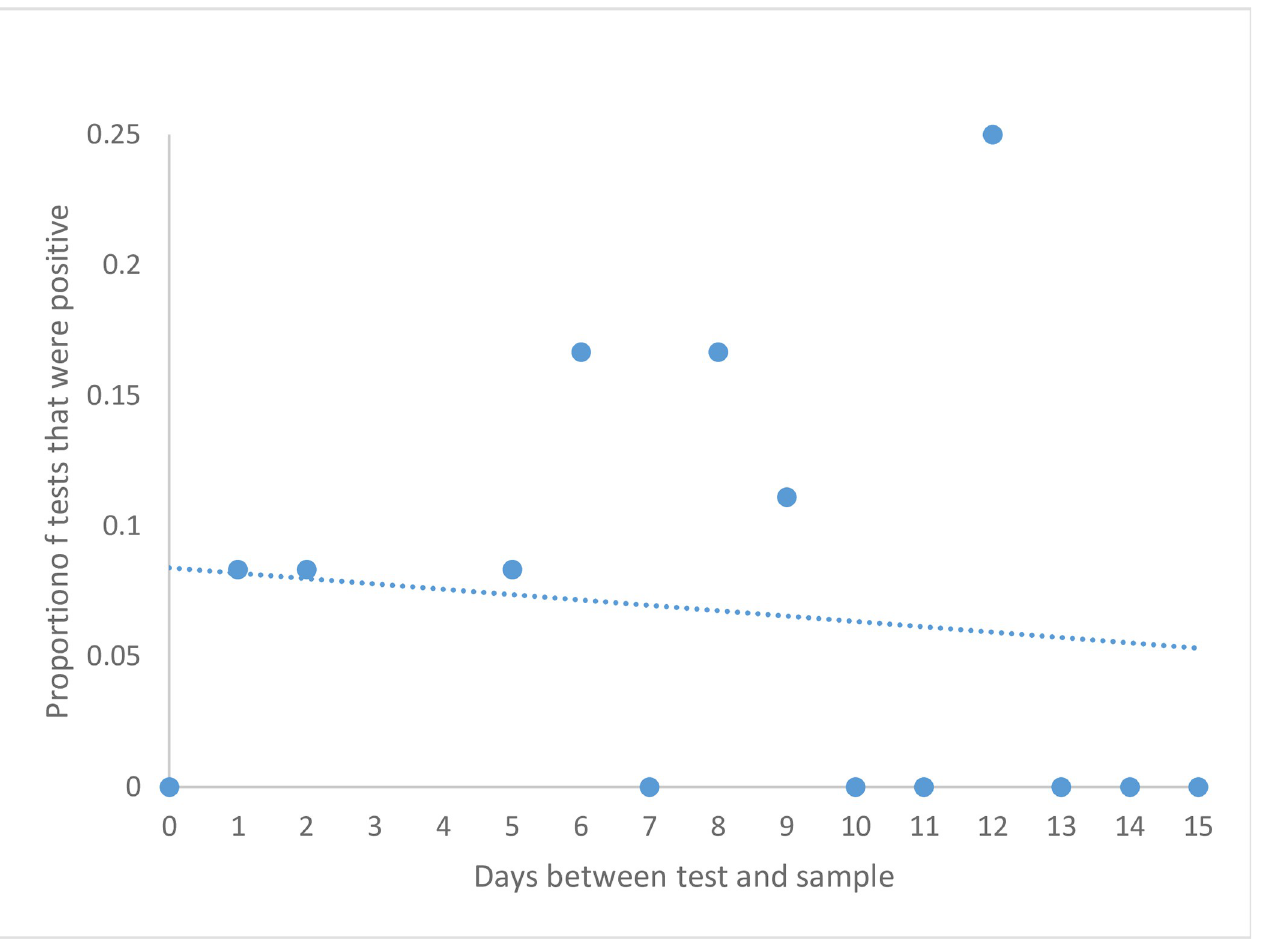
Fig 2. Positive samples association from date of PCR test. The time between the collection date of the PPE sample and the patient’s last positive COVID-19 PCR test was compared to the percent of positive PPE and bag samples (total).